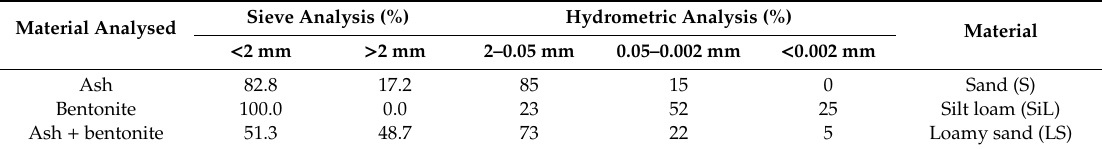
Table 3. Grain-size composition of ash, bentonite and the granulate produced from them.